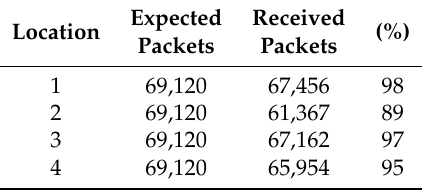
Table 2. Percentage of received packets based on the manufacturer’s setting for hourly broadcasts.